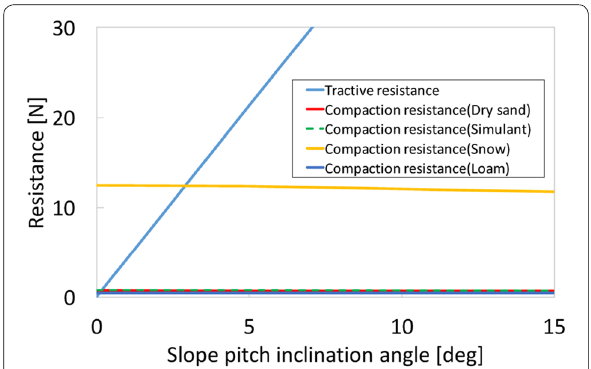
Fig. 3 Resistances acting on the robot climbing a